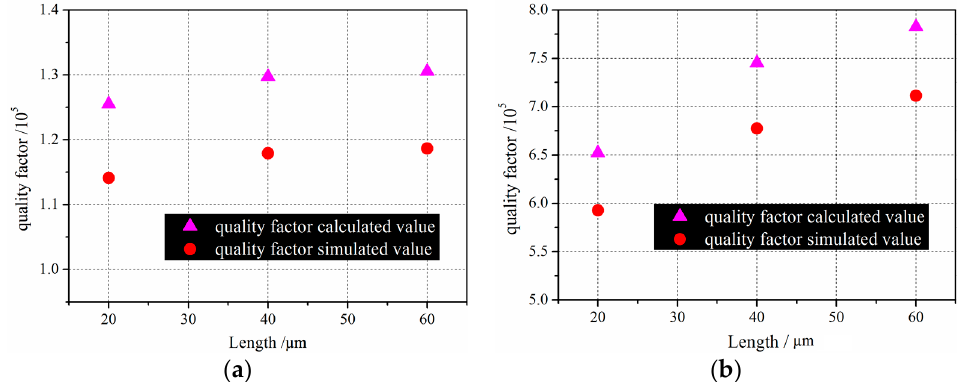
Figure 15. The compared Q values of the drive ‐ mode and sense ‐ mode of micro ‐ comb finger versus different lengths (20 μ m, 40 μ m, 60 μ m). ( a ) drive ‐ mode and ( b ) sense ‐ mode.